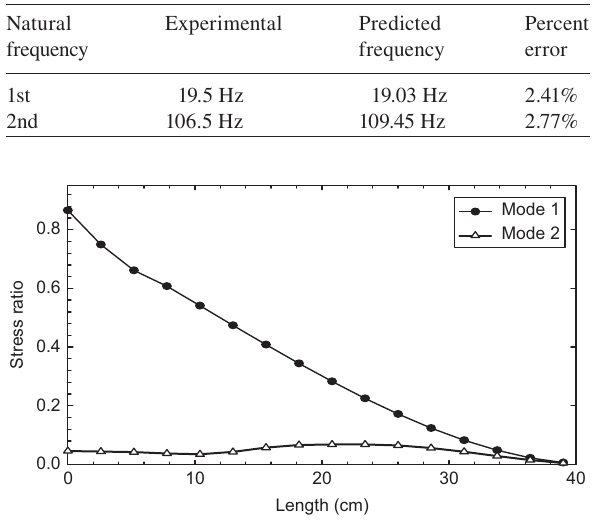
Figure 1 Comparison of the Von Misses centerline stress profi le for the fi rst two fl exural transverse natural frequencies.